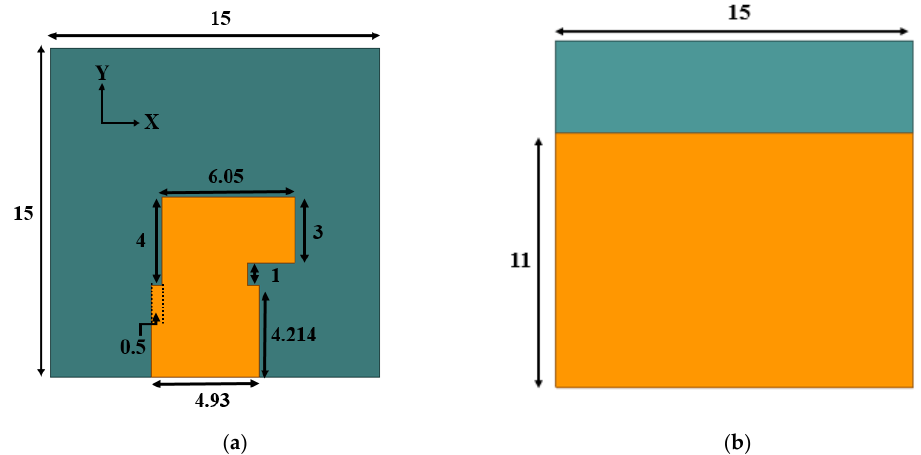
Figure 1. Unit element antenna geometry with truncated ground: ( a ) front side; ( b ) back side.